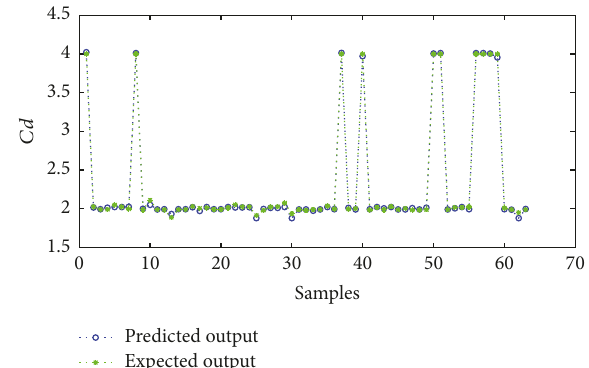
Figure 15: Comparisons of the drag ratio of the AUV fleet by BPNN and